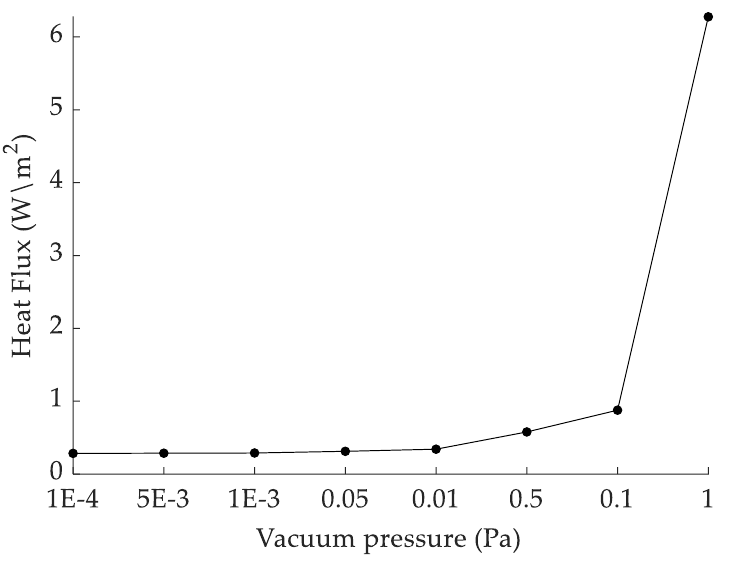
Figure 7. Variation in heat flux with the pressure.